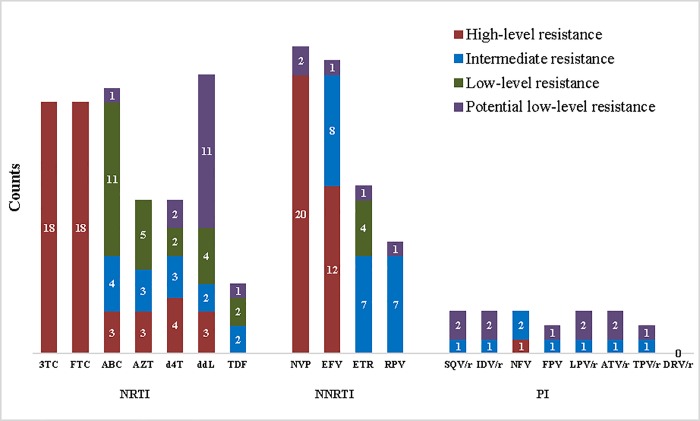
Frequency and levels of HIV-1 drug resistance to various antiretroviral drugs among ART-experienced patients.NRTI: Nucleotide reverse transcriptase inhibitors [3TC: lamivudine; FTC: emtricitabine; ABC: abacavir; AZT: zidovudine; d4T: stavudine; ddl: didanosine; TDF: tenofovir]. NNRTI: Non-Nucleoside reverse transcriptase inhibitors [NVP: nevirapine; EFV: efavirenz; ETR: etravirine; RPV: rilpivirine]. PI: Protease inhibitors [SQV/r: saquinavir; IDV/r: indinavir FPV/r: fosamprenavir; LPV/r: lopinavir; ATV/r: atazanavir]. Red represent high-level resistance, blue represent intermediate resistance, green represent low-level resistance and purple represent potential low-level resistance.